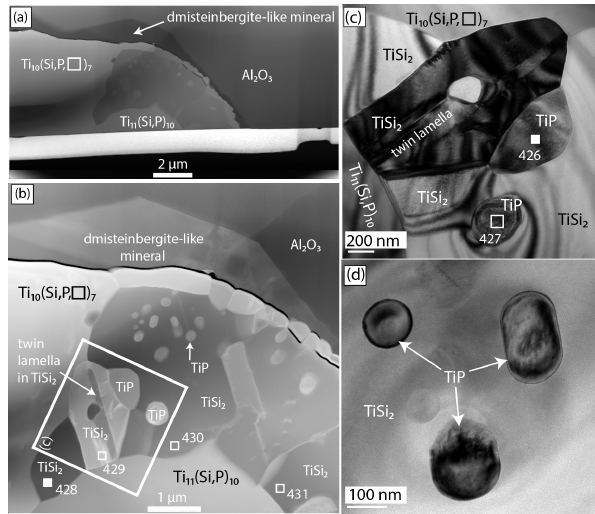
Figure 3. (a) High-angle annular dark-field scanning transmis- sion electron microscope (HAADF-STEM) image of foil no. 5358 showing an aggregate of zhiqinite (TiSi 2 ), enclosing globules of badengzhuite (TiP) and surrounded by Ti 10 (Si,P, (cid:3) ) 7 , Ti 11 (Si,P ) 10 , and the dmisteinbergite-like mineral. (b) Al 2 O 3 – corundum host- ing the Ti silicide inclusion. Source areas for EDX analyses are numbered squares; filled squares indicate locations where data for the structure were obtained: no. 426 (badengzhuite) and no. 428 (zhiqinite). (c) TEM (transmission electron microscopy) bright- field image of the area inside the large square shown in (b) . (d) TEM bright-field image of globular badengzhuite in zhiqinite. HAADF and bright-field images obtained at the GFZ German Research Cen- tre for